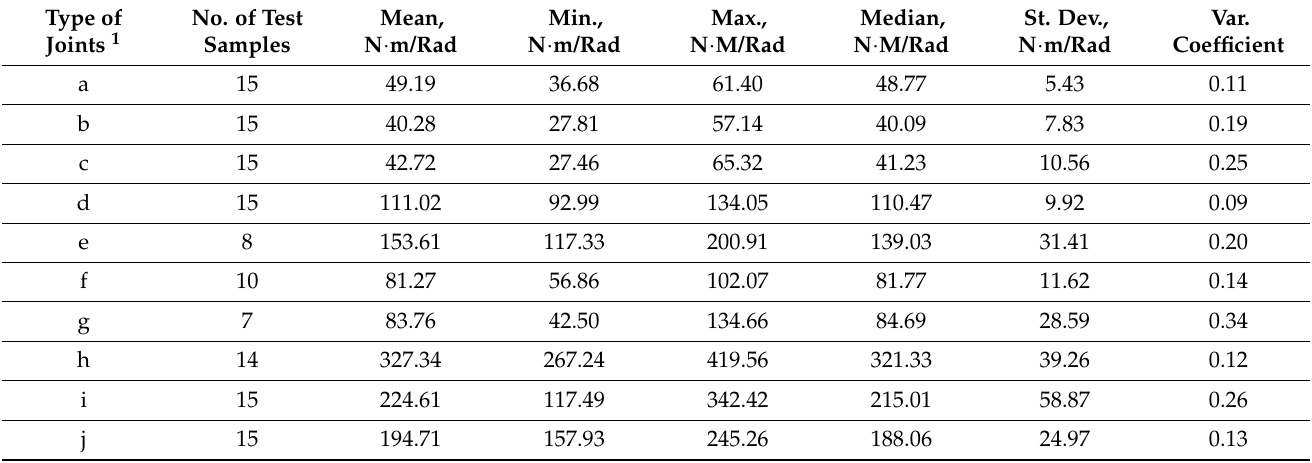
Table 4. Stiffness coefficients of corner joints made of lightweight